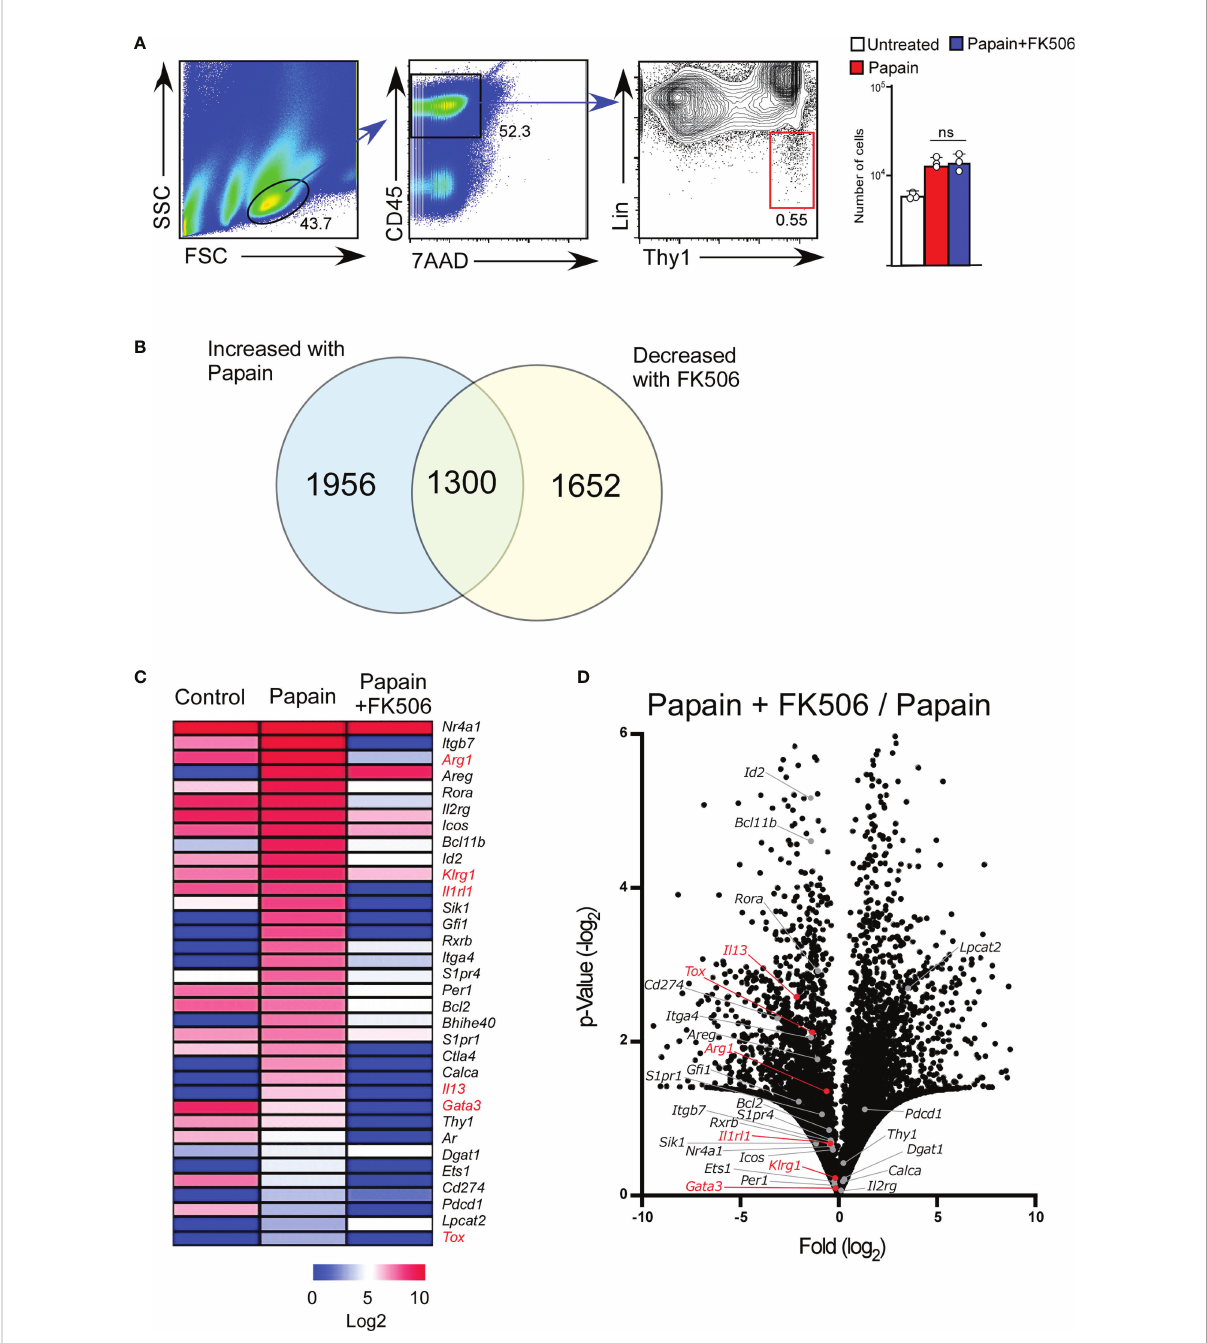
FIGURE 4 FK506 inhibits the papain-induced activation signal of ILC2 cells. Total RNA was isolated from lung ILC2 cells on day one after papain administration. We compared the results with and without FK506 treatment, as shown in Figure 1. RNAseq libraries were sequenced using the HiSeq platform. (A) Gating strategy and the number of lung ILC2 cells (untreated, n=3; papain-administered with or without FK506 treatment, n=3 each). CD45 + lineage marker (Lin)-Ty1 + ILC2 cell populations are marked with a red square. (B) Venn diagram of genes whose expressions were increased by papain (>2-fold) and decreased by FK506 (<2-fold). (C) Heat maps representing the FPKM values of ILC2 signature genes in lung ILC2 cells. The data indicate untreated (control) and papain-administered mice with (Papain + FK506) or without (Papain) FK506. (D) Volcano plots represent the fold-change expression (horizontal axis) and p-values (vertical axis) in the papain versus papain + FK506 comparison. ILC2 signature genes are shown in gray (n=3). ILC2 activation marker genes (Arg1, Gata3, Il13, Tox, Klrg1, and Il1rl1) are highlighted in red. Data are representative of four mice. Bars represent the means; not signi fi cant (ns) using unpaired Mann-Whitney